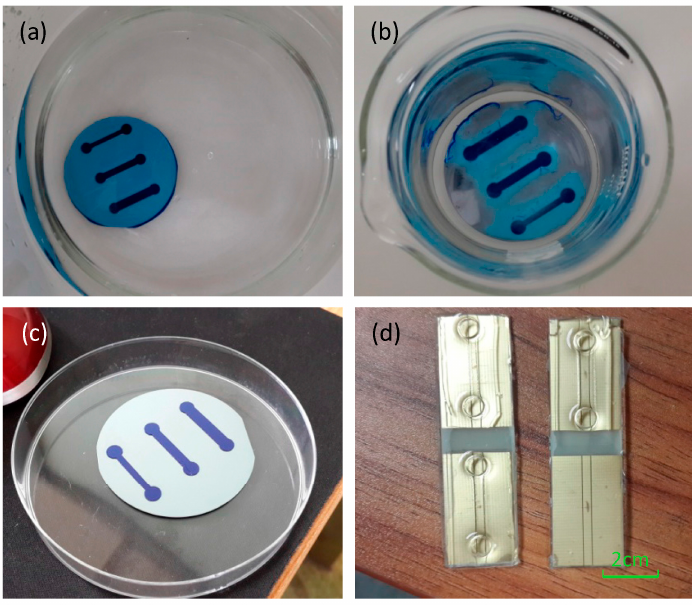
Figure 2. Fabrication of microchannel. The development procession at ( a ) 0 min; and ( b ) after 20 min; Panel ( c ) shows three channels (1 mm, 2 mm and 3 mm); Panel ( d ) shows microchannels.